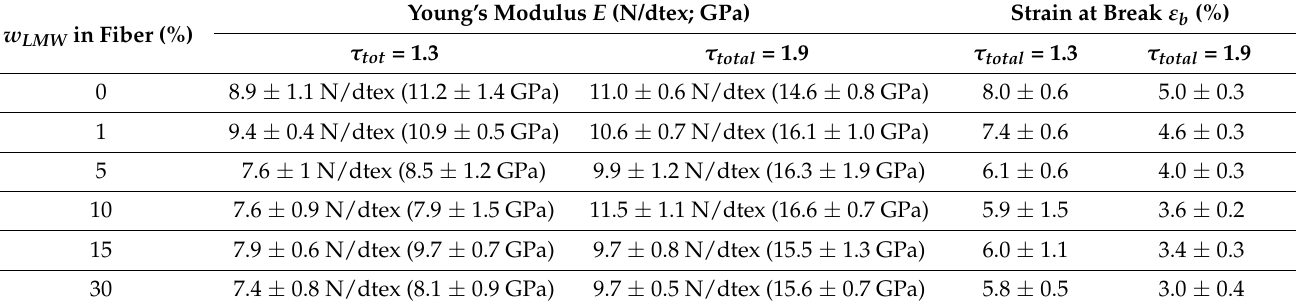
Table 4. Young’s modulus E , and strain-at-break ε b obtained from stress–strain curves obtained by the uniaxial tensile testing of spun fibers with different contents of LMW chitosan w LMw , using different stretching ratios τ total of 1.3 and 1.9. The tensile tests were performed at 35% relative humidity.